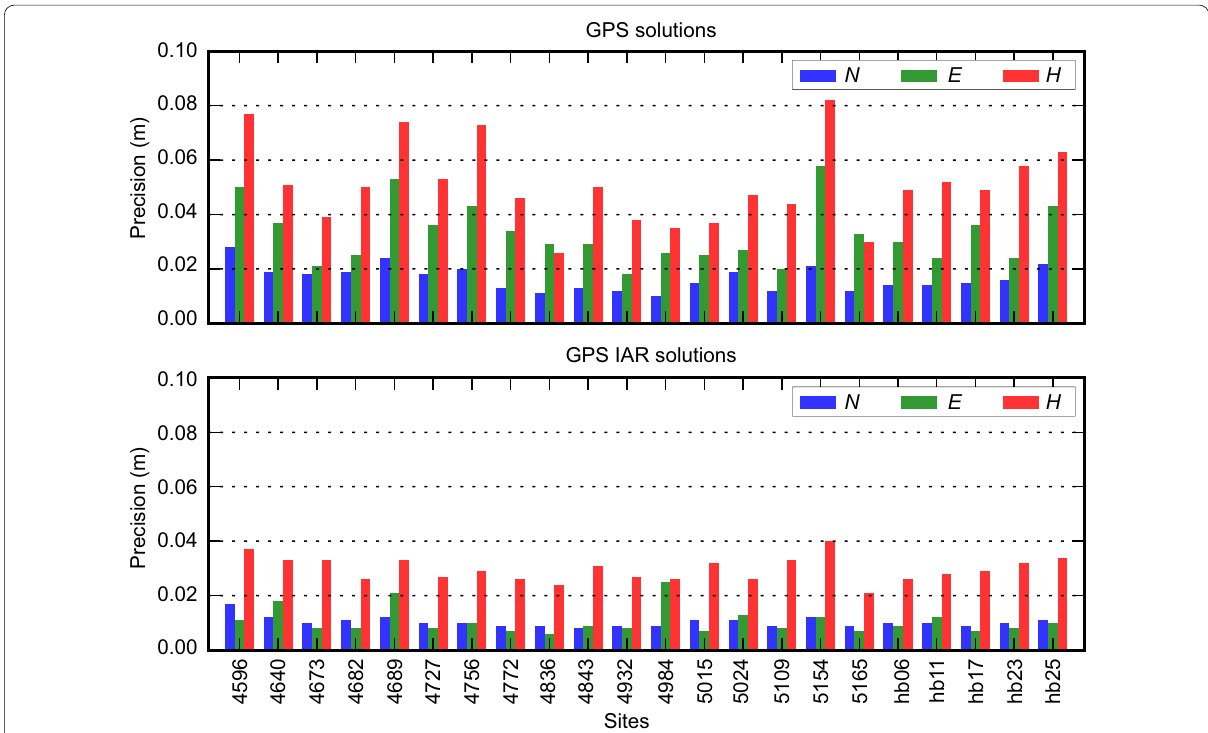
Fig. 6 GPS only PPP (top) and PPP-IAR (bottom) solutions for North (blue), East (green) and Height (red)